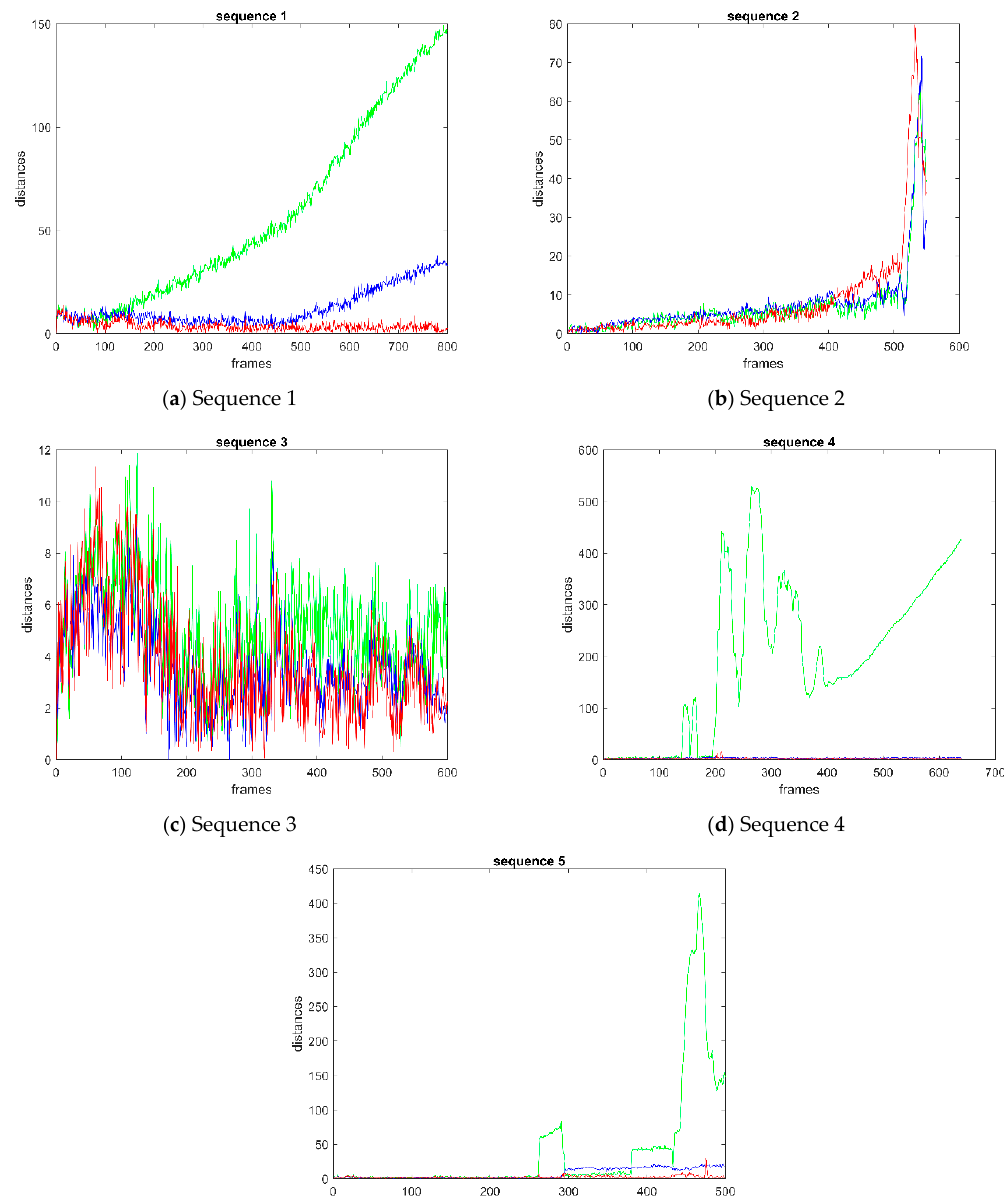
Figure 10. Curve of distance between predicted box and real box: ( a ) sequence 1; ( b ) sequence 2; ( c ) sequence 3; ( d ) sequence 4; ( e ) sequence 5; ( f ) sequence 6; ( g ) sequence 7. The points on the curves denote the distance between the center of the predicted bounding box and the ground-truth bounding box.